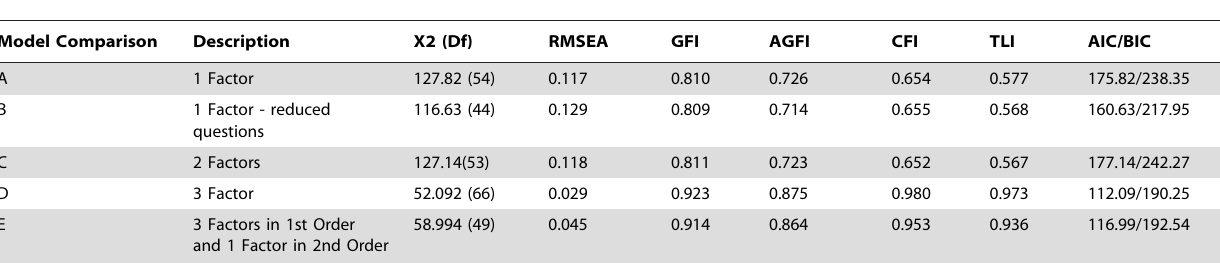
Table 4. Confirmatory factor analysis’ models fit indicators comparison.